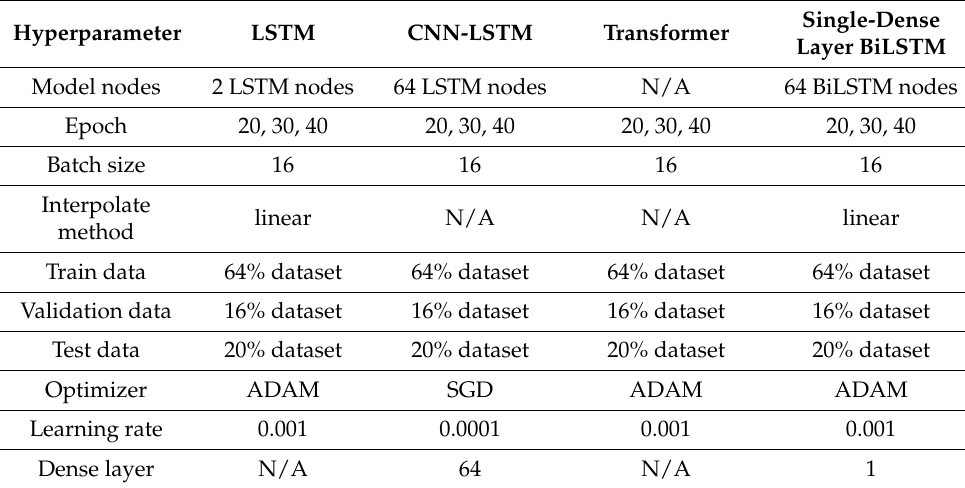
Table 1. List of hyperparameters values of LSTM, CNN-LSTM, Transformer, and Single-Dense Layer